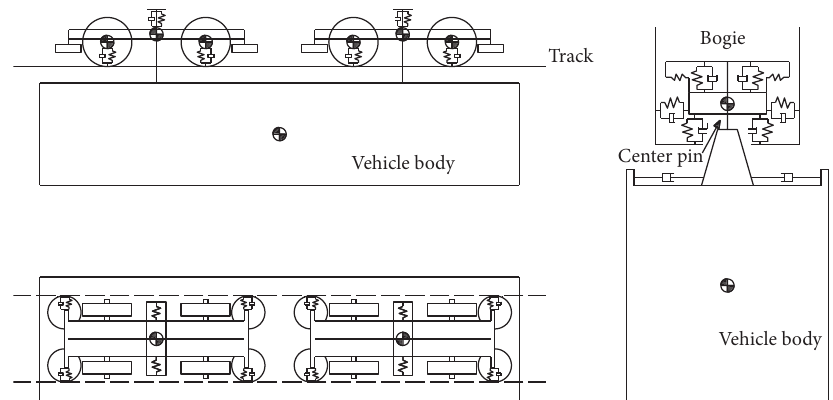
Figure 1: Dynamic model of suspension monorail vehicle.